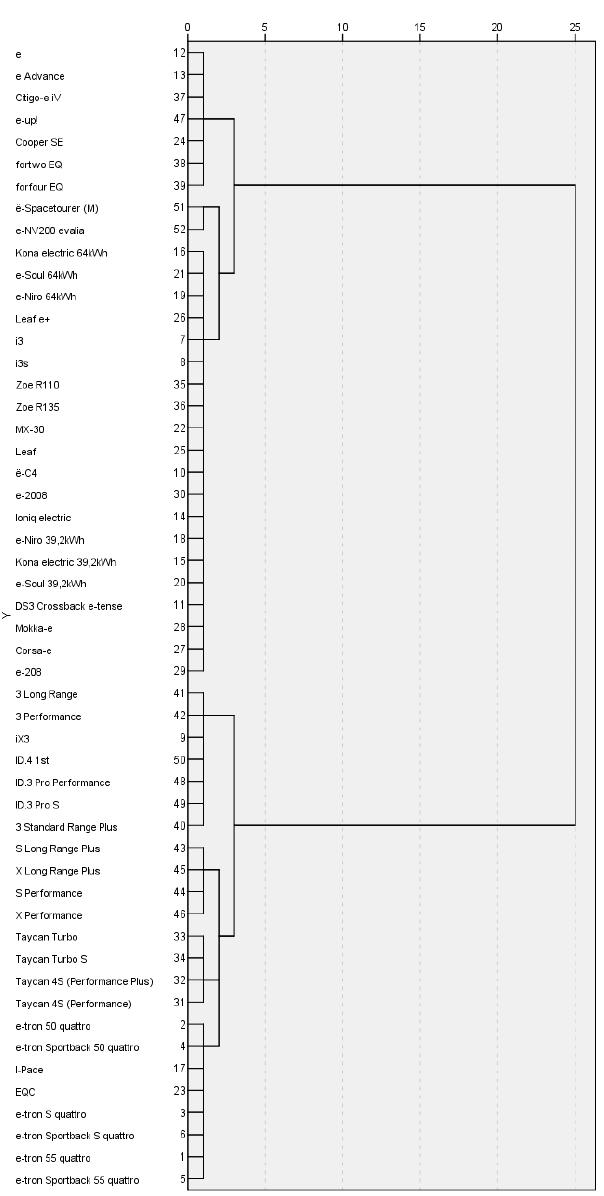
Figure A2. The process of merging into cluster (including boot capacity, excluding price). Based on the available data, the relationship between “energy consumption” and “engine power” variables was also examined (see Figure A3). However, due to the large lack of data (over 10%), this analysis was not presented in the main text. As the engine power increases, the energy consumption increases on average. This relationship is ap- proximately linear. It should be indicated that a strict correlation occurs when outliers in